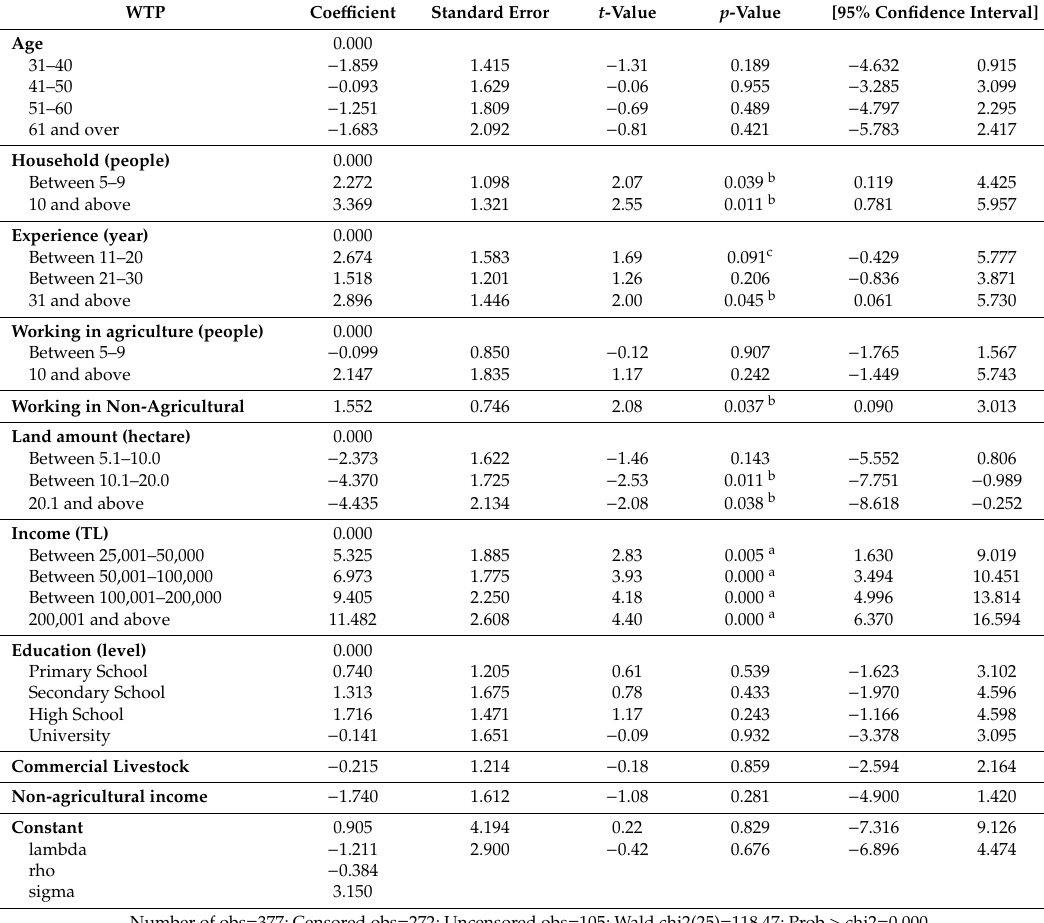
Table 3. The Heckman’s second-stage model, OLS model / payment model, estimation results.